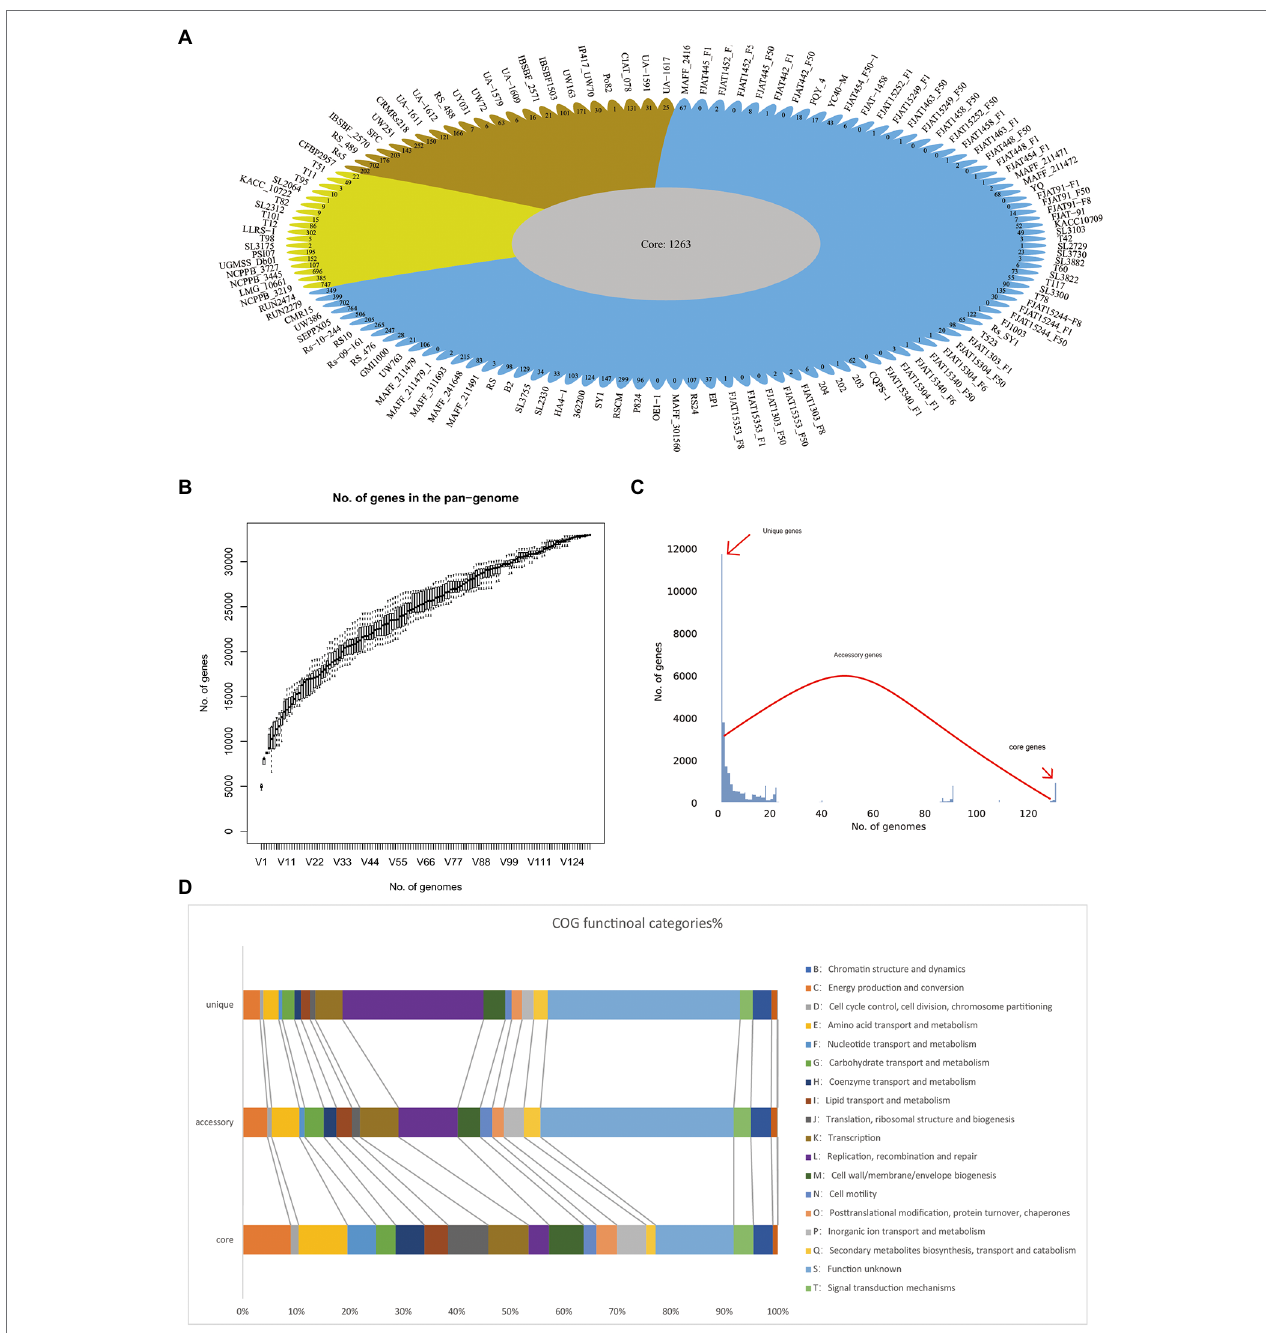
FIGURE 2 | Pangenome shape and function of RSSC. (A) The pangenome flower plot showing the core genome and different unique gene for each strain, the different colors correspond with the different groups in the core genome tree. (B) Gene accumulation curves for the pangenome, the cumulative sizes were calculated by selecting strains without replacement in random order 1,000 times. (C) A histogram of the prevalence of different gene families in the pangenome. A total of 30,763 non-redundant gene families identified in 131 genomes are based on their frequency distribution. Three gene categories are clearly distinguished, highlighting the unique genes (genes that only exist in one strain), core genes (gene families are present in more than 120 strains), and accessory genes (gene families that exhibit variable frequencies). (D) Distribution of COG categories in the core, accessory, and unique